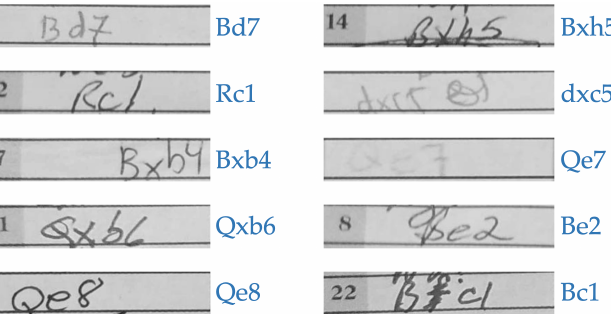
Figure 11. Clear samples ( left ) and messy samples ( right ) from the HCS dataset [23]. Original moves are annotated beside the samples in